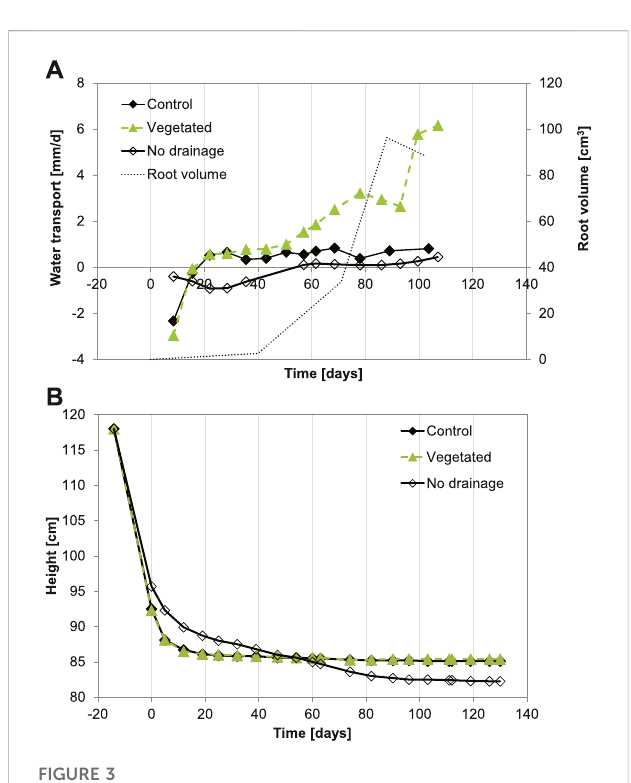
FIGURE 3 (A) Water transport and (B) bed elevation measured during the experiments. Negative values for water transport indicate fl ow toward the drainage pipe, and positive values indicate fl ow from this pipe into the